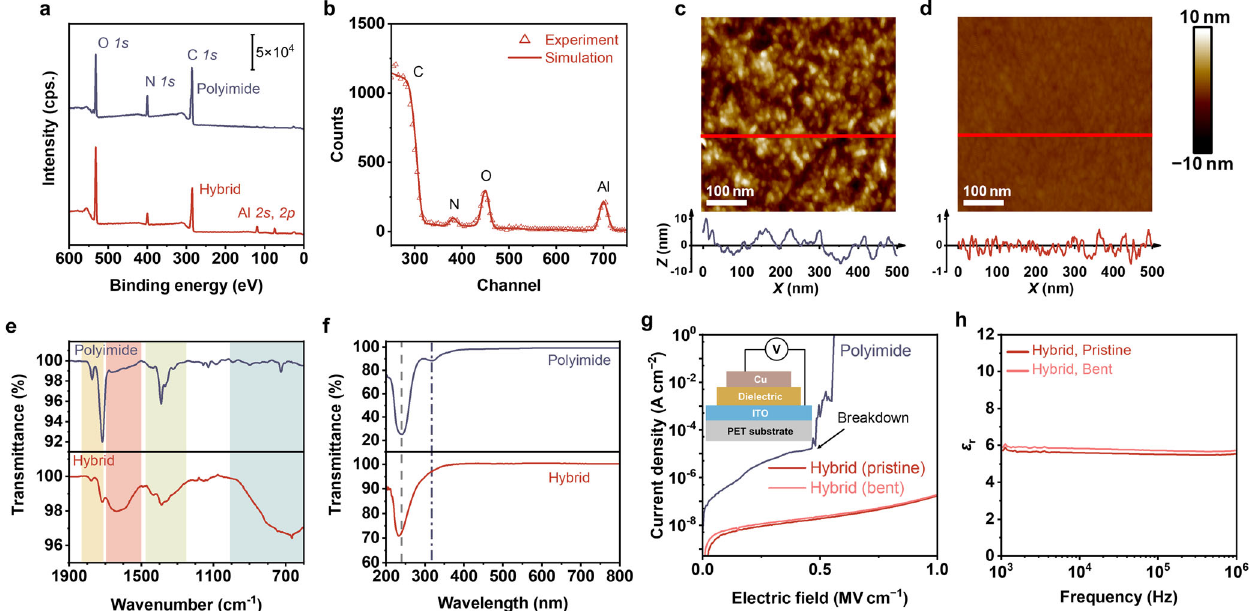
Fig. 2 Material characterization of the polyimide and the hybrid fi lms. a XPS survey spectra of a polyimide fi lm and a hybrid fi lm. b RBS experimental and simulated spectra for a hybrid fi lm grown on a fl at glassy carbon substrate. AFM images of c a polyimide fi lm and d a hybrid fi lm grown on fl at Si wafer substrates. Bottom pro fi les present the height traces of the line sections labeled in the above images. c FTIR spectra of a polyimide fi lm and a hybrid fi lm grown on KBr plates. f UV – vis spectra of a polyimide fi lm and a hybrid fi lm grown on glass substrates. g Leakage current of the MIM capacitors with the polyimide or hybrid dielectric (inset schematically illustrates an MIM capacitor structure). h ε r of the hybrid dielectric as a function of